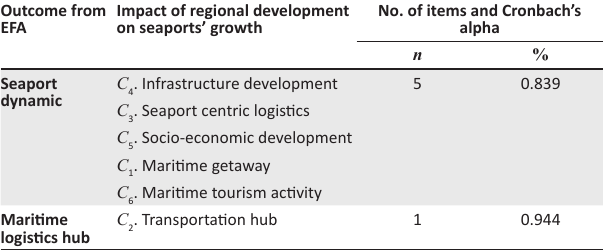
TABLE 5: Reliability test on the exploratory factor analysis results (Section C). Outcome from EFA